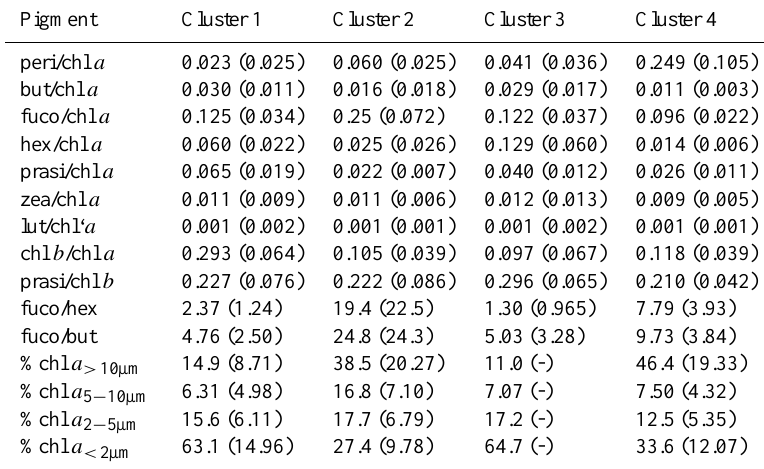
Fig. 2. Dendrogram showing phytoplankton groups that were separated by cluster analysis using pigment composition data. The red line indicates the location of the similarity index ( = 0.57) that divided the clusters into four groups. Numbers on the x axis indicate the sample IDs. Table 1. Means and standard deviations of pigment/chl a and pigment/pigment ratios and percent contribution of size fractionated chl a to the total that were used in this study to determine the dominant phytoplankton groups in each cluster. Standard deviations are shown in parentheses. Note that since we obtained only one size-fractionated chl a sample that classified into cluster 3, standard deviations of %chl a are not shown for cluster 3. Pigment Cluster 1 Cluster